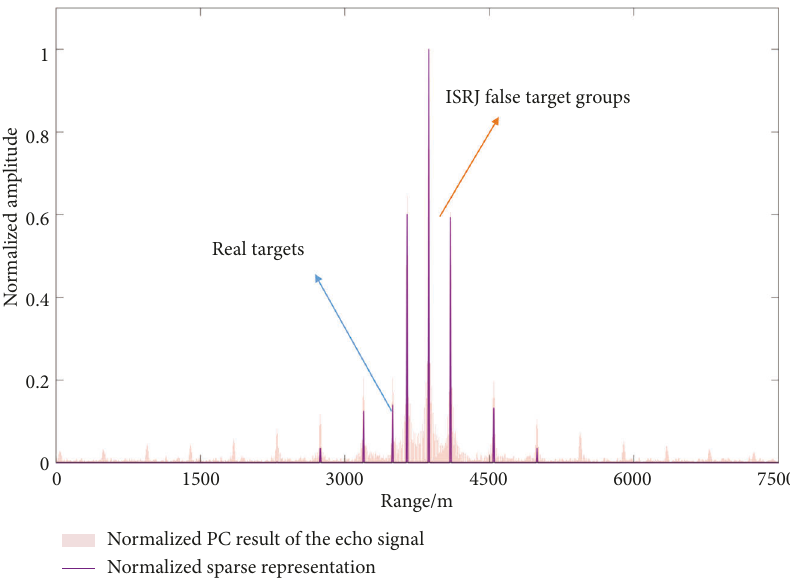
Figure 12: Spare representation of the echo signal in the target aliasing situation.